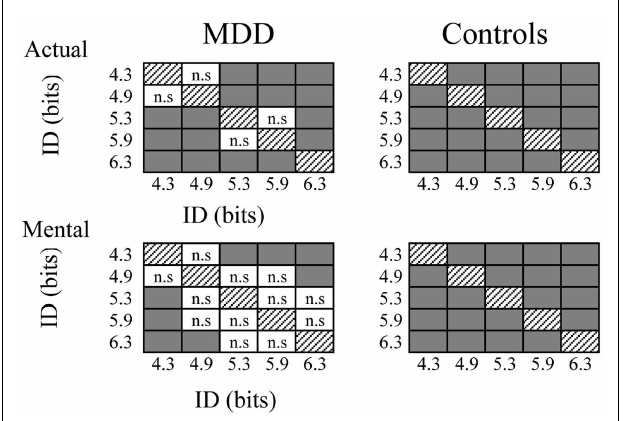
FIGURE 4 | Schematic representation of post hoc analysis regarding the influence of the index of difficulty on mental and actual movement times of both groups . Gray squares indicate significant differences ( P > 0.05), whereas white squares with indicate non-significant (n.s.) differences.